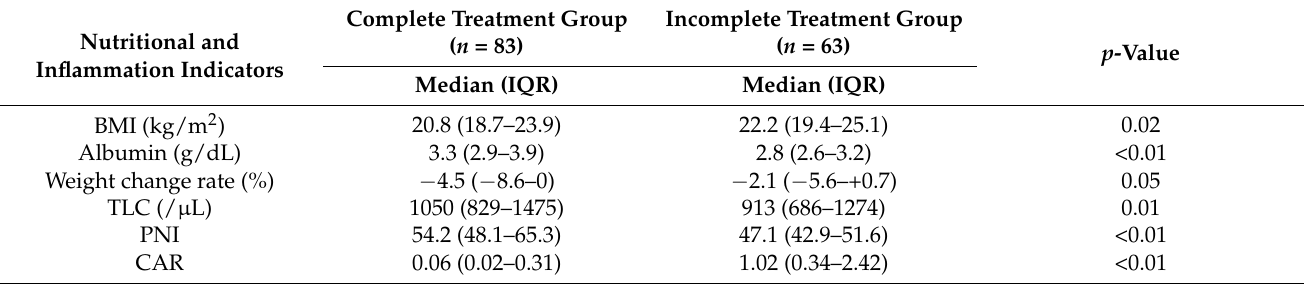
Table 2. Comparison of nutritional indicators between the complete and incomplete treatment